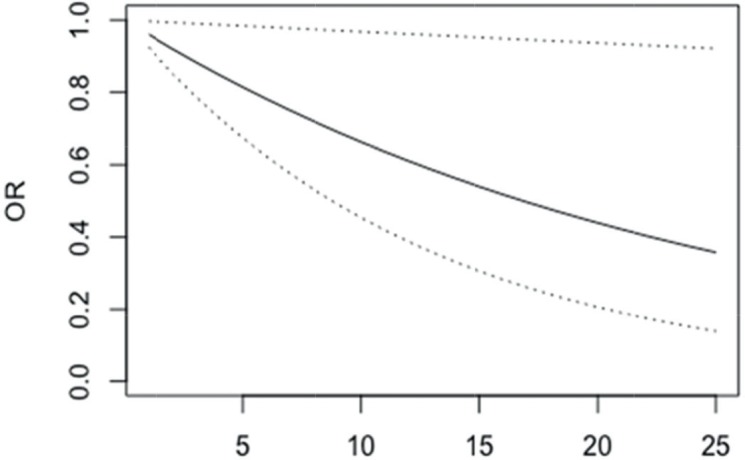
OR of not having depression in patients with differences in the BRBS scale scores between 1 and 25 points (95% confidence bands for the OR are shown in dash lines).